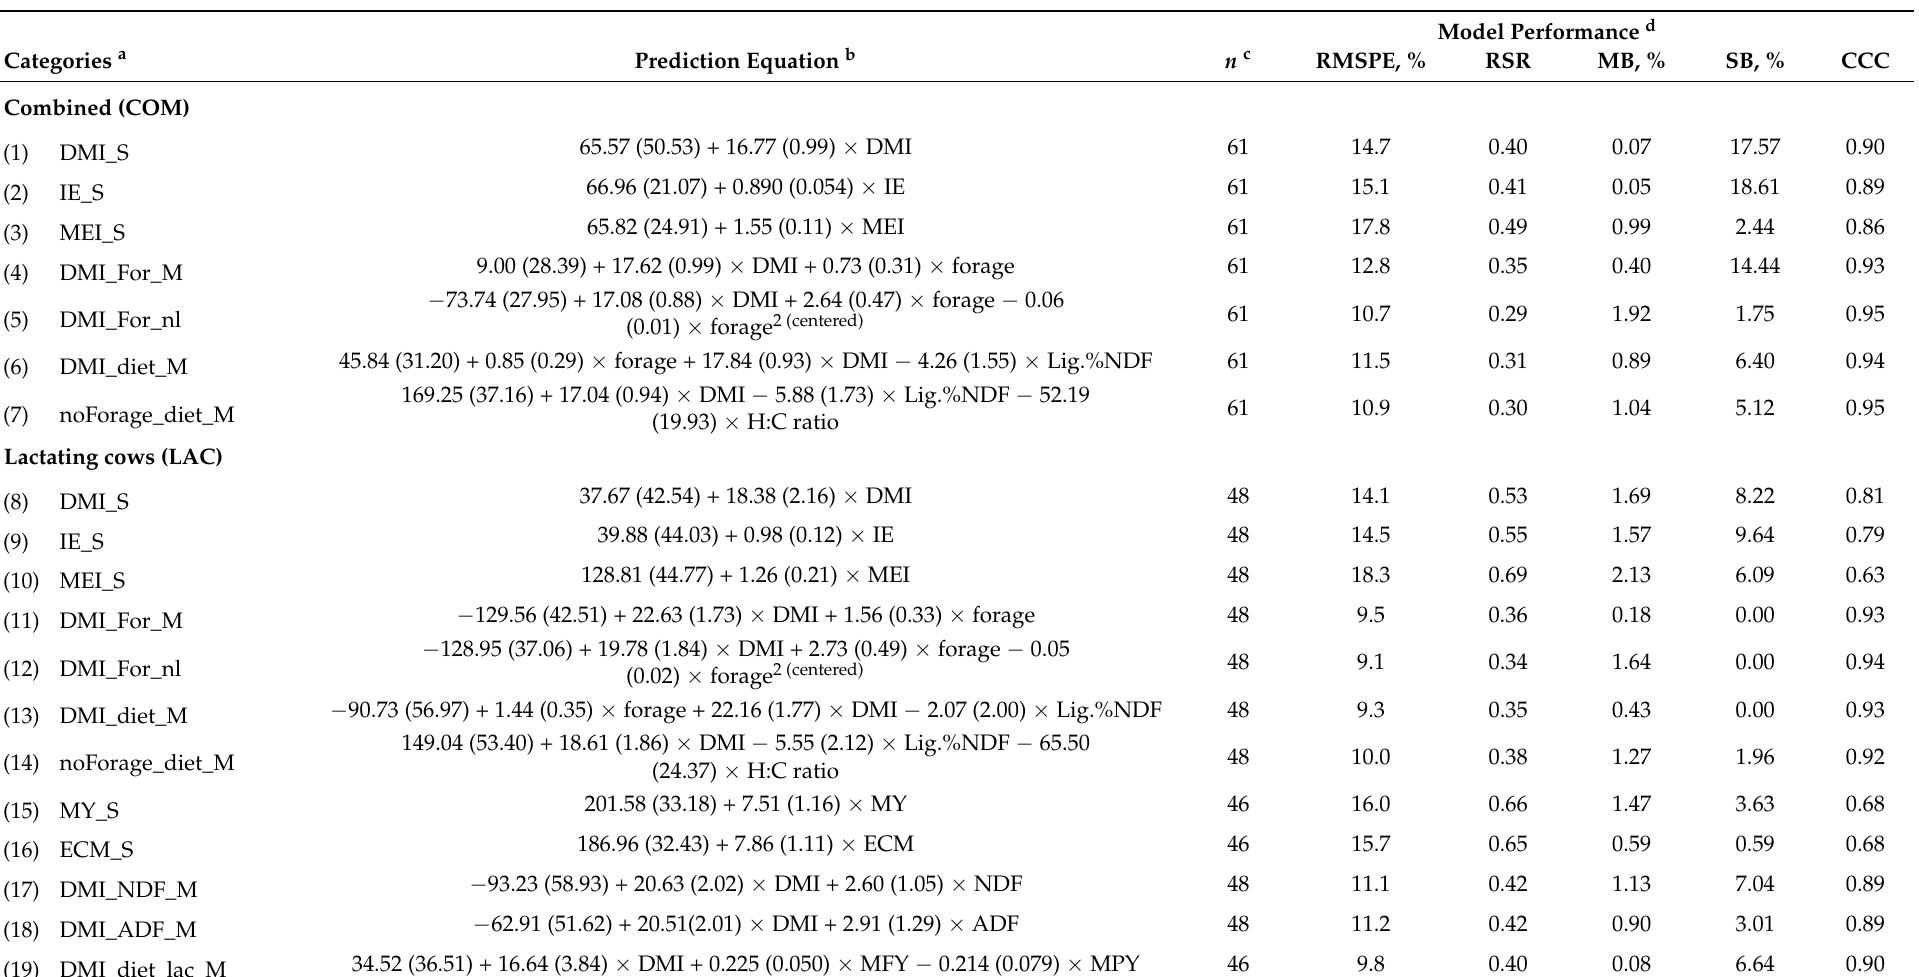
Table 3. Methane production (g/d) developed prediction equations and model performance evaluation using combined (COM) and lactating cows (LAC) databases.